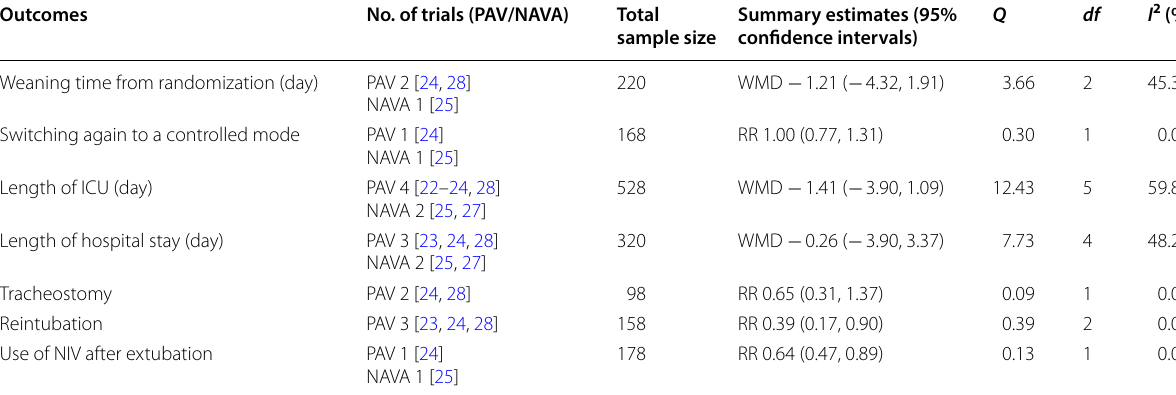
Table 3 Results of secondary outcomes